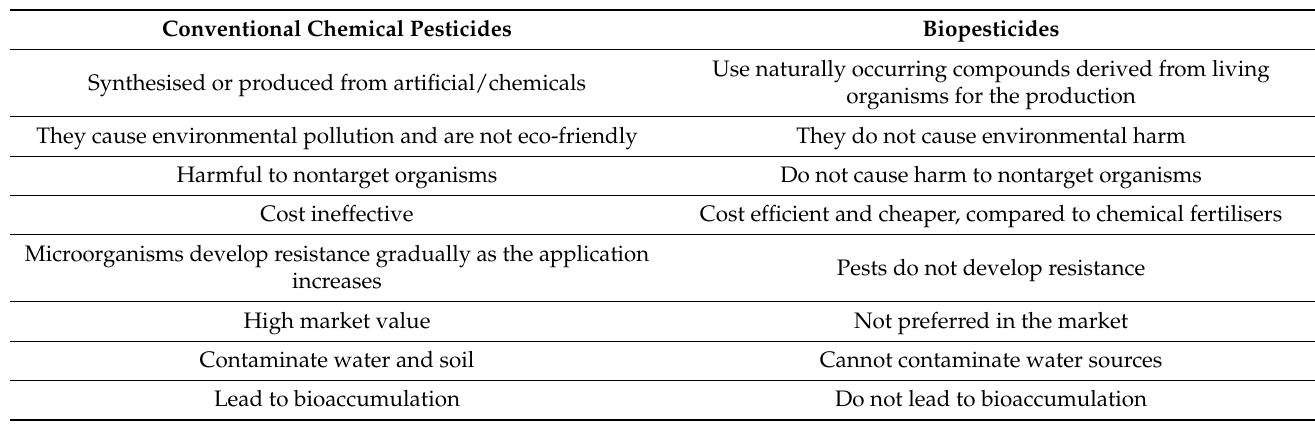
Table 2. The various disadvantages of conventional chemical pesticides over biopesticides. Conventional Chemical Pesticides Biopesticides Use naturally occurring compounds derived from living Synthesised or produced from artificial/chemicals organisms for the production They cause environmental pollution and are not eco-friendly They do not cause environmental harm Harmful to nontarget organisms Microorganisms develop resistance gradually as the